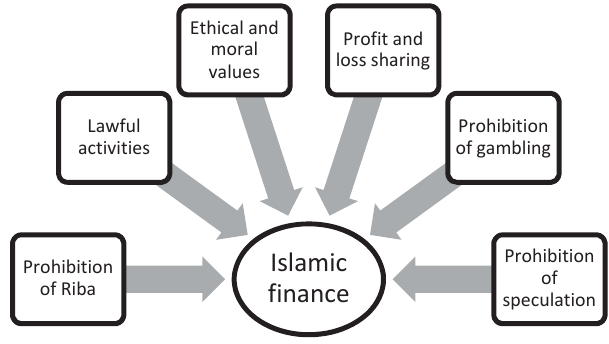
Fig. 1. Basic rules of Islamic finance